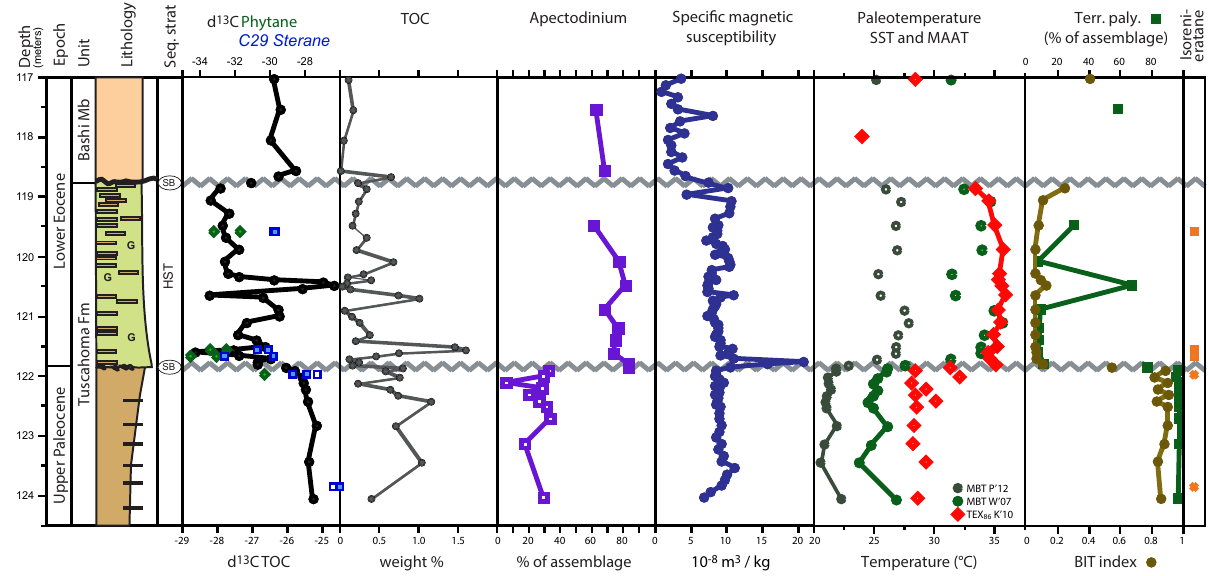
Figure 3. Paleontological and geochemical records across the PETM in the Harrell Core. Schematic lithological units represent the (in brown) upper Paleocene heterogeneous brown, gray siltstone/mudstone; the (in green) PETM glauconitic (G) sands and silts; and the (in light brown) early Eocene siliciclastics of the lower Bashi Mb. Small dark brown boxes within siltstone represent the presence of fine mud layers throughout; rounded symbols at base of glauconitic unit represent coarse sand. Light-colored and open symbols in the δ 13 C values of sulfur-bound phytane and sulfur-bound C 29 sterane yield a relatively high uncertainty of ∼ 1 and ∼ 1.5‰ in isotope values, respectively, due to the low abundance of these compounds in the sediments. Upper Paleocene Apectodinium abundances (open squares) should be considered rough estimates; average Paleocene values are 27% (see text and Supplement Table S1). Calibration-related errors on absolute temperatures for TEX 86 and MBT–CBT temperatures are 2.5 and 5 ◦ C, respectively. Open TEX 86 (diamonds) and MBT (circles) symbols indicate temperatures that may be biased by high supply of terrestrial lipids or in situ production, respectively (see text). Pollens and spores versus dinocysts dominantly determine the ratio of terrestrial versus marine palynomorphs. Crosses at isorenieratene indicate intervals where this biomarker was not